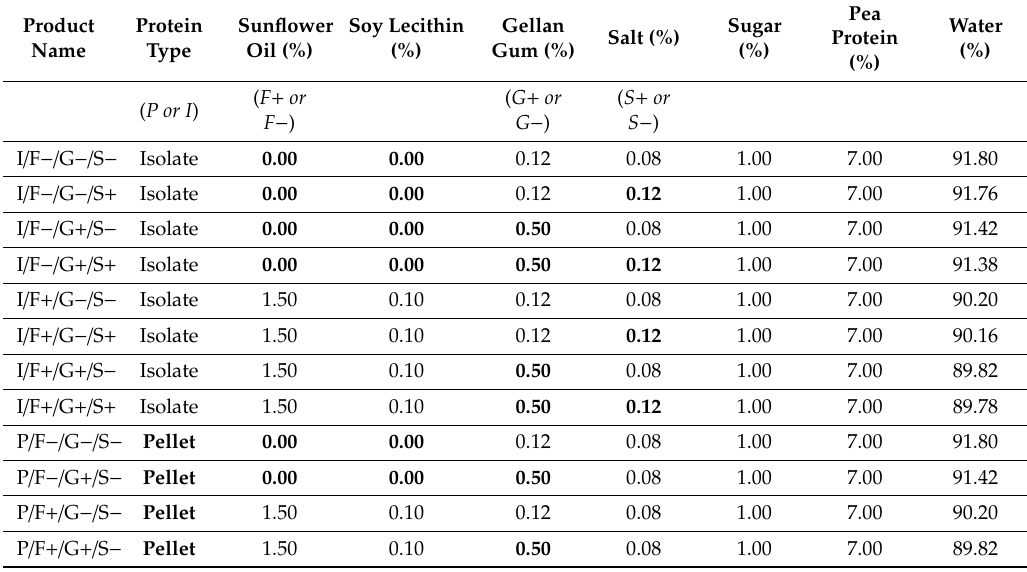
Table 1. Composition (ingredient concentrations [w / w %]) of the pea protein-based beverages used in this study. Abbreviations: I = isolate, P = pellet, F + = 1.5% oil, F − = 0% oil, G + = 0.5% gellan gum, G